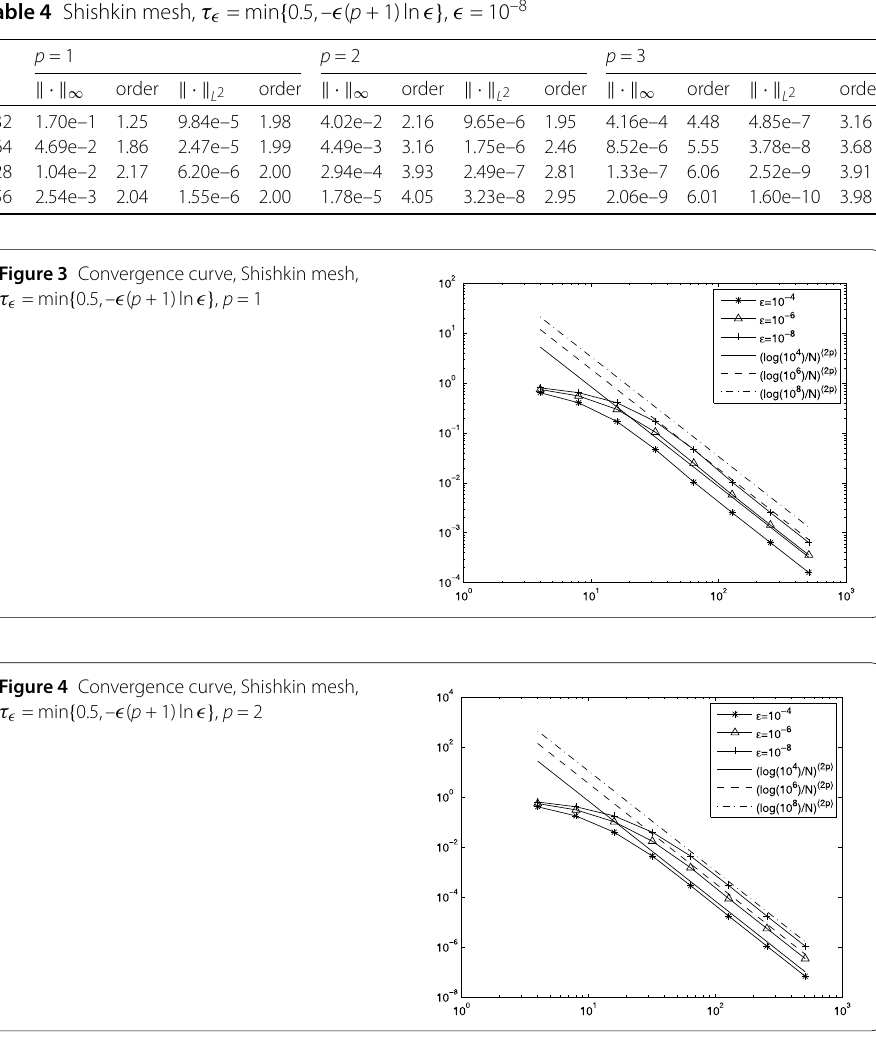
norm for (cid:2) = 10 –6 and (cid:2) = 10 –8 , respectively. Taking (cid:2) as 10 –4 , 10 –6 , and 10 –8 , Fig. 3 and Fig. 4 demonstrate the convergence curve of the numerical solution